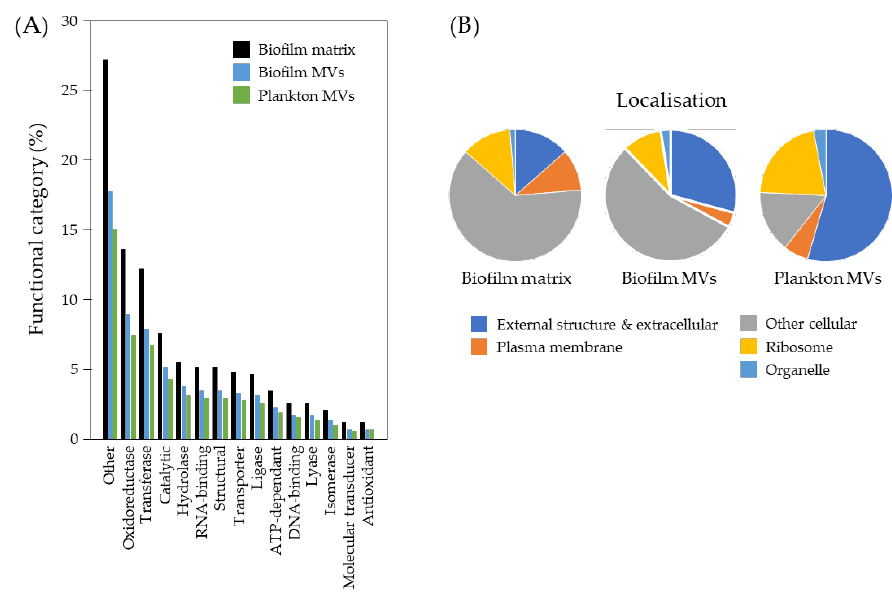
Figure 7. P. fluorescens SBW25 Wrinkly Spreader biofilm matrix and membrane vesicles have different protein profiles. Proteins associated with the biofilm matrix and membrane vesicles (MVs) isolated from biofilms and plankton (shaken cultures) were identified by MALDI-TOF mass spectrometry and categorized according to GO functional activities and predicted localization. Shown here (left) are the top 15 functional ( A ) and five cellular localization ( B ) categories for proteins identified from biofilm matrix samples, biofilm vesicle and planktonic vesicle samples.